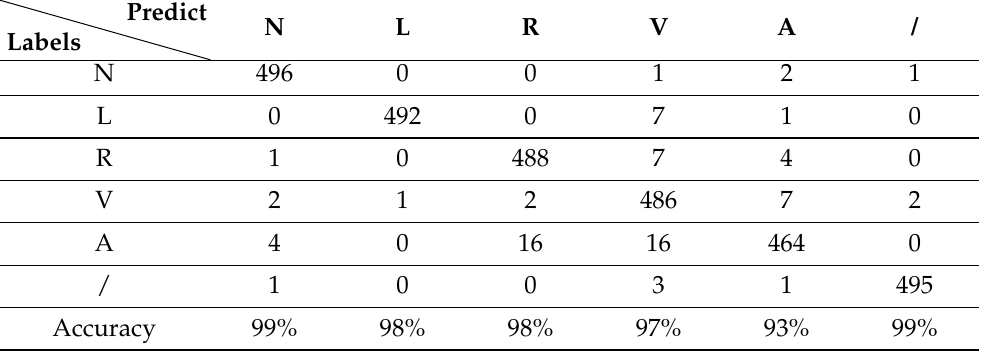
Table 7. Detection results for all six labeled ECG heart